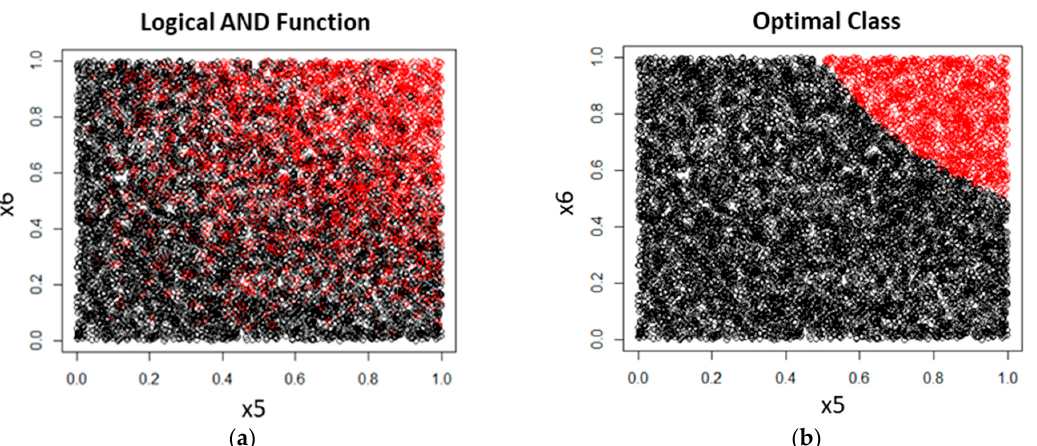
Figure 4. Class allocation for the XOR data set as a function of x 3 and x 4 showing: ( a ) The stochastic class labels; ( b ) The correct classes used to find the optimal AUC; ( c ) The two-way interaction term identified by the Dirac measure; and ( d ) The interaction estimated with the Lebesgue measure, which is almost identical to the curve in ( c ). Both surfaces are the only terms in the GAM, and closely correspond to the logit of the ideal XOR prediction surface. The main difference to theory is that the values at the four corners that saturate at finite values, whereas in theory, they extend to infinity in both vertical directions. This, however, has little impact on the crucial region for classification, which is the class boundary.